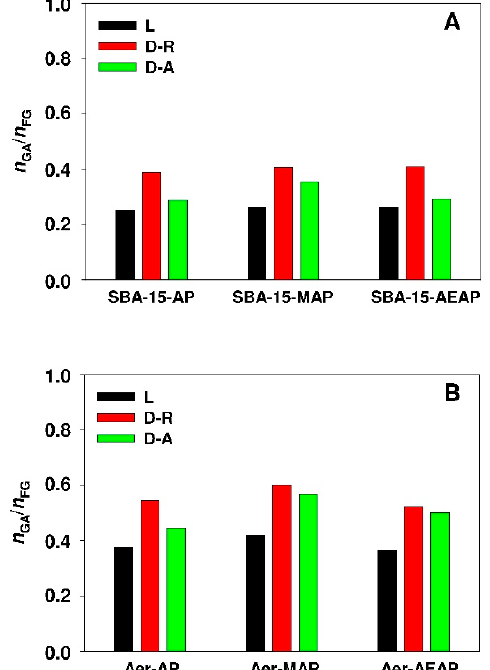
Figure 14. Molar ratio of 18 β -glycyrrhetinic acid molecules to functional group content of ( A ) modified SBA-15 silicas and ( B ) modified Aerosil ® siliacas. The ratio calculated from maximum adsorption capacity established from nonlinear fitting analysis. Isotherms: D-A, Dubinin-Astakhov; D-R, Dubinin-Radushkevich; L, Langmuir.